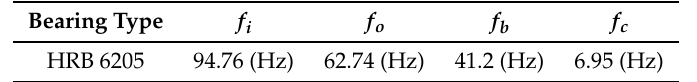
Figure 19. Experimental bearing with multiple faults on the surfaces of the inner race and outer race. Table 4. The theoretical calculation result of characteristic frequencies of rolling bearing